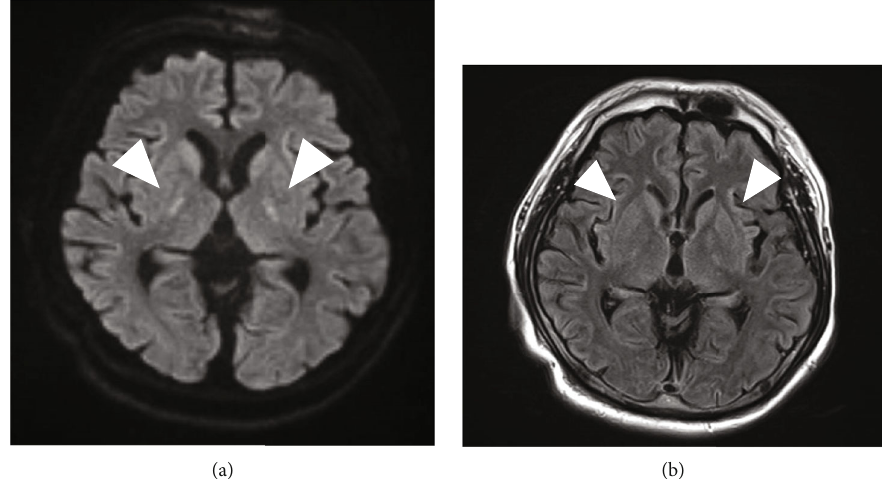
Figure 3: MRI on day 10 revealed only symmetrical hyperintensity in the putamen and posterior limb of the internal capsule (arrow). (a) DWI; (b) FLAIR. DWI: di ff usion-weighted image; FLAIR: fl uid-attenuated inversion recovery; MRI: magnetic resonance imaging.